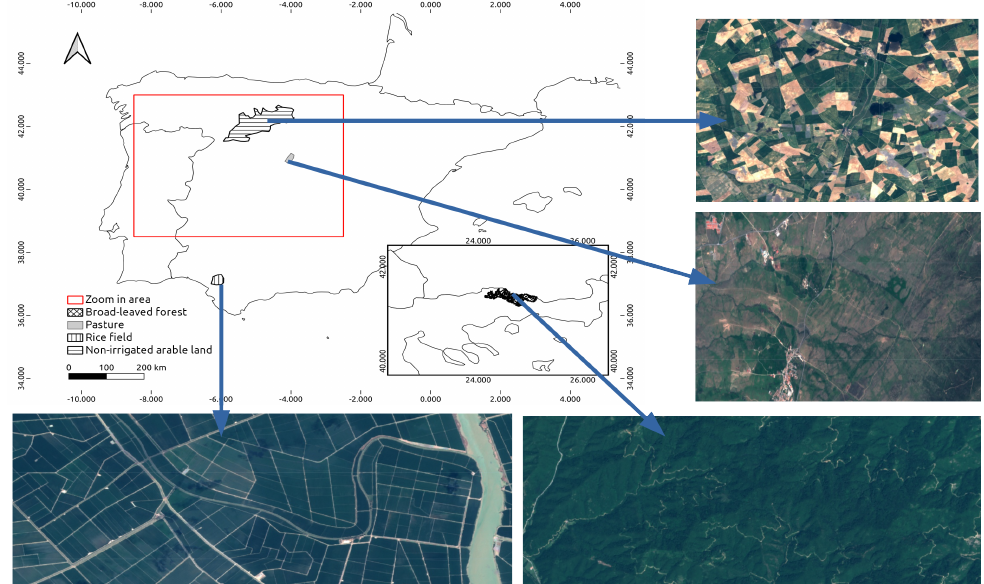
Figure 2. CLC areas used for time series analysis. For more comprehensive insights, RGB captures were taken from Sentinel-2 scenes with GSD of 20 m, at different dates. Counterclockwise: rice field, broad-leaved forest, pasture land and non-irrigated arable